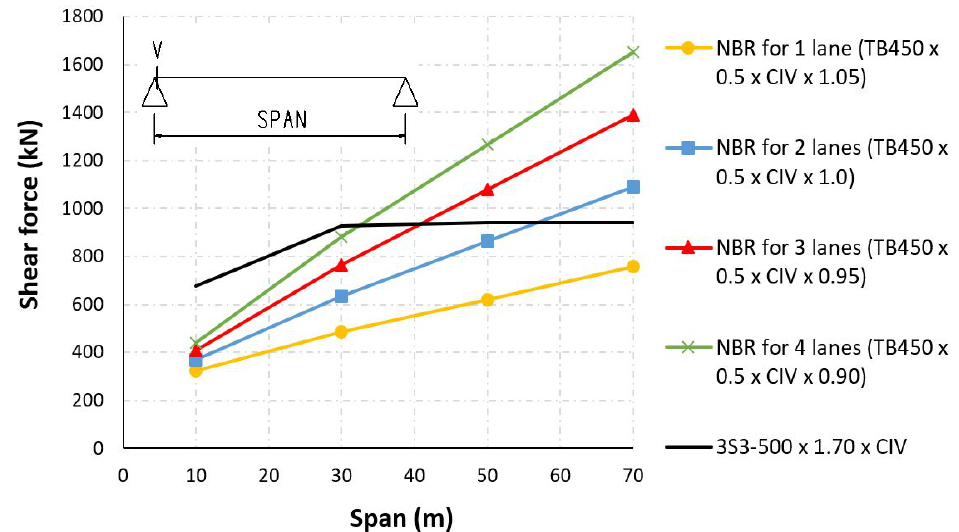
Figure 25. Comparison between models for shear force at support in simply supported bridges